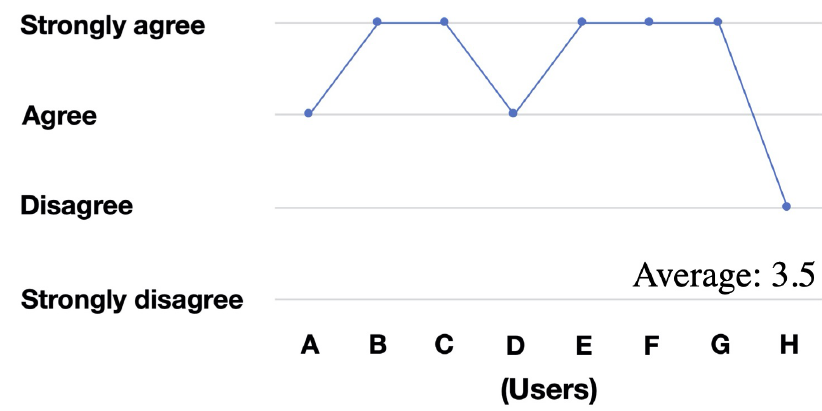
Figure 19. Usability evaluation of the